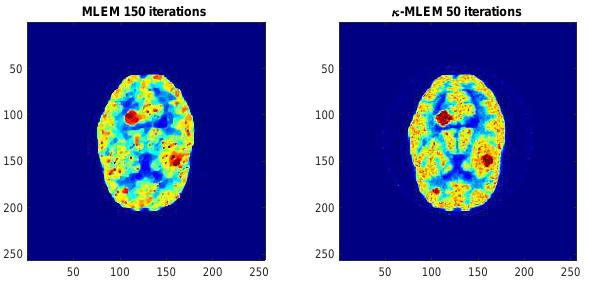
Figure 6. Comparative analysis of reconstructing a Hoffman phantom using various reconstruction methods by varying the iteration number.